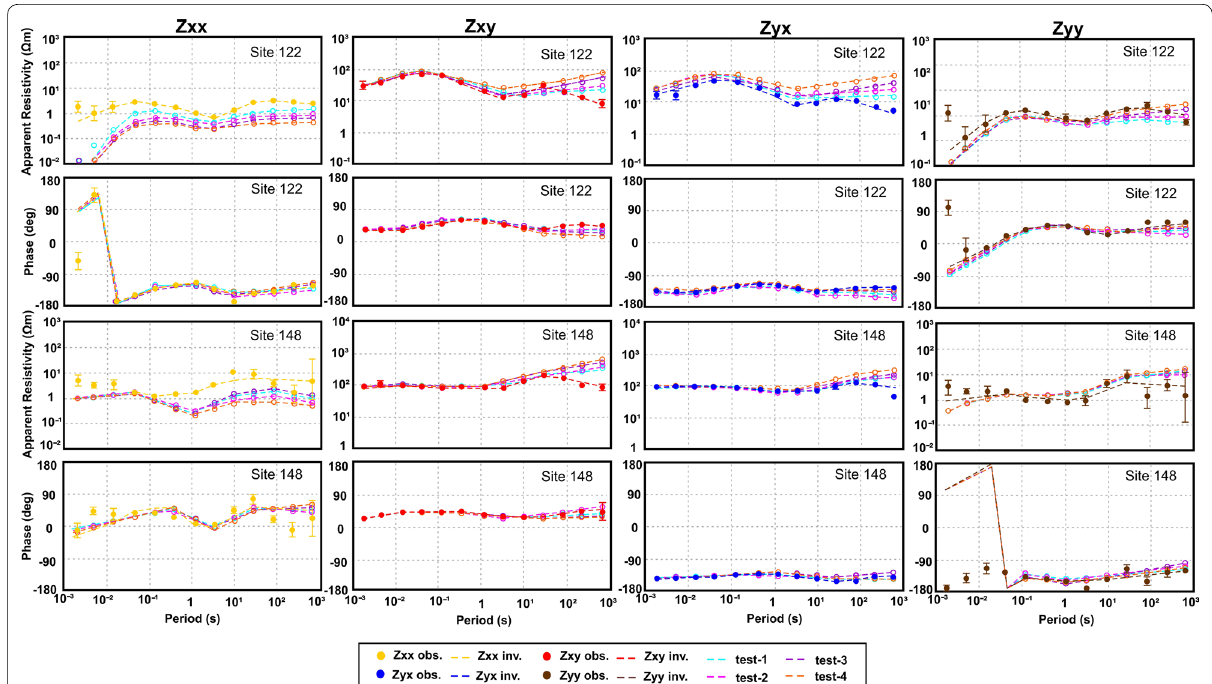
Fig. 8 MT sounding curves at two representative sites (122 and 148) for sensitivity tests with artificially inserted resistive bodies. The location of the sites is shown in Fig. 1b. The sites 122 and 148 are located above the conductive features C1 and C2,